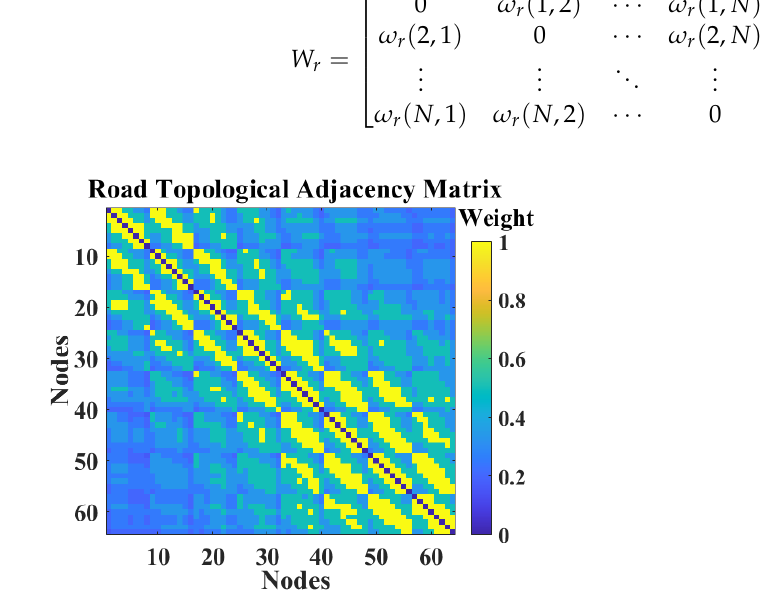
Figure 7. The road topological adjacency